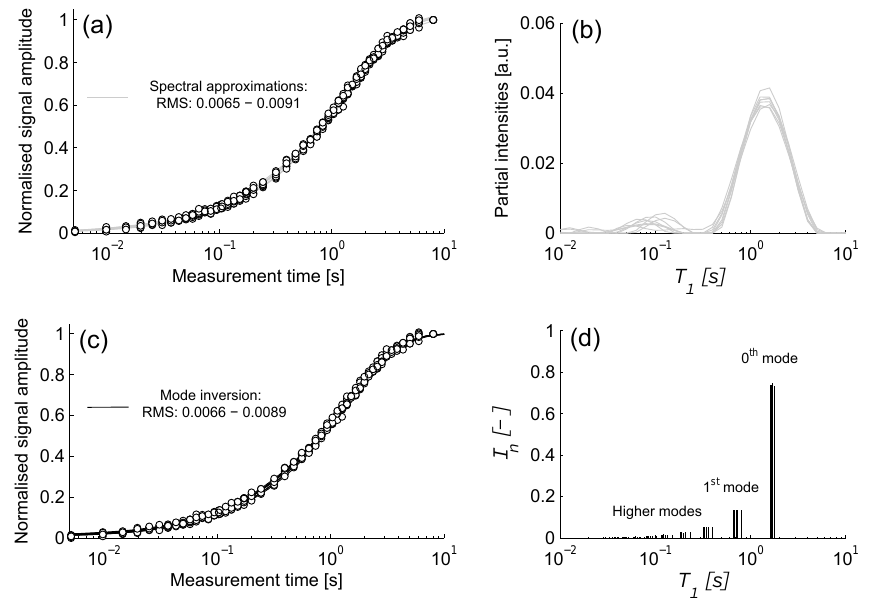
Figure 3. Panels (a) and (c) : normalised T 1 measurements at different heights of sample F4 after homogenisation and corresponding approx- imations using (b) multi-exponential spectrum and (d) relaxation